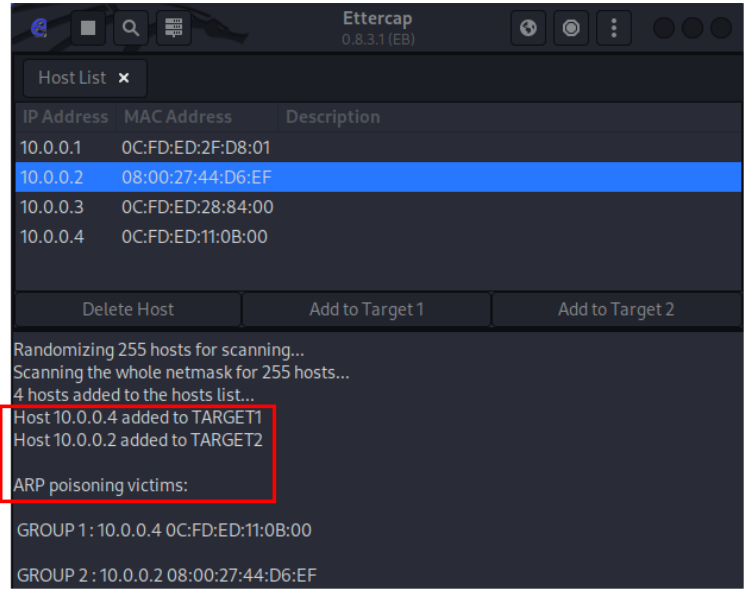
Figure 17. Ettercap ARP poisoning (ANS and